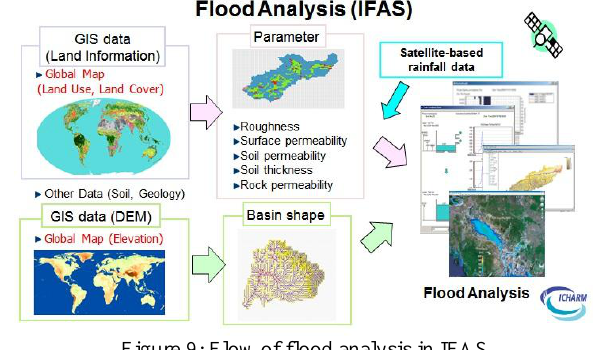
Figure 9: Flow of flood analysis in IFAS